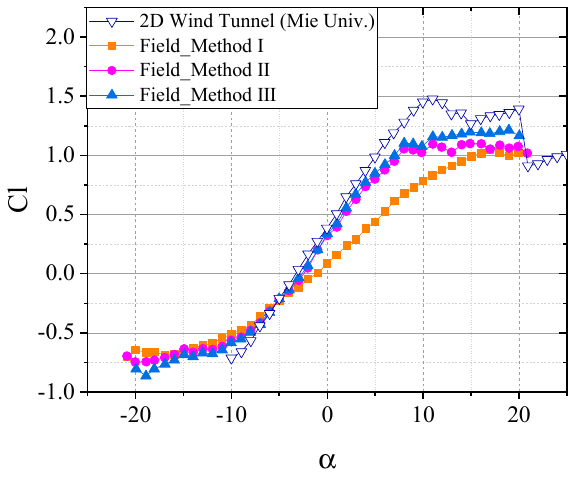
Figure 18. Comparison of lift coefficients of DU93-W-210 between the field test and 2D wind tunnel test.